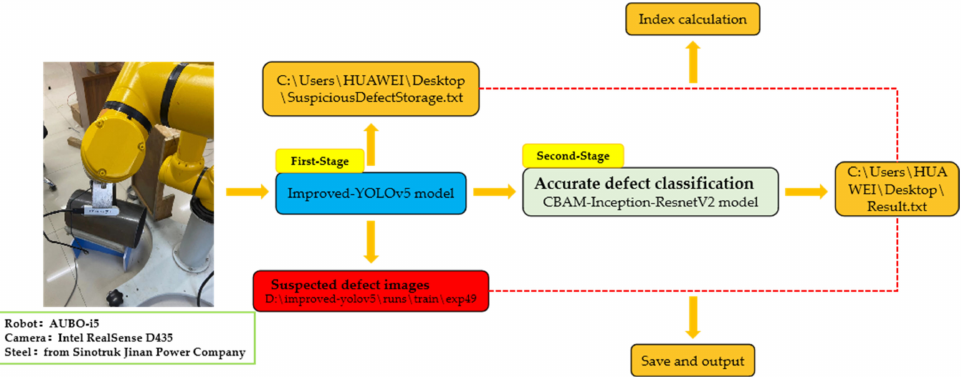
Figure 16. The implementation process of an industrial